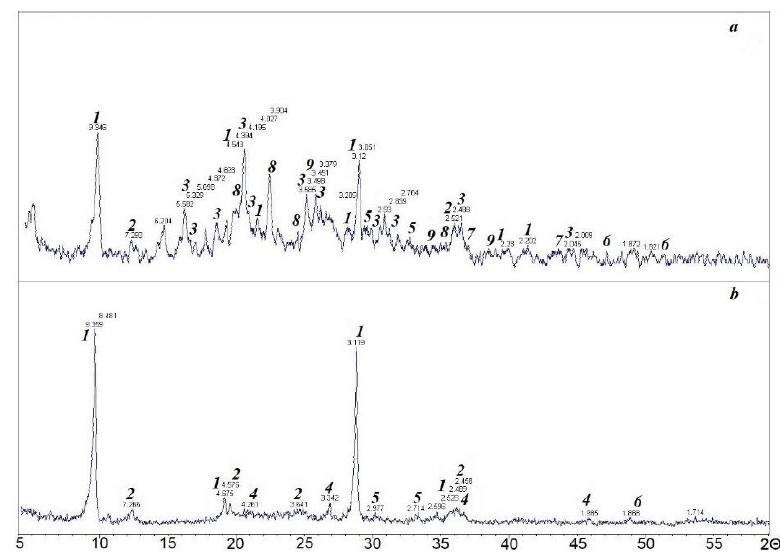
Figure 5. XRD pattern of the clinker after roasting at 450 °C ( a ) and of the leaching residue ( b ). Numbers indicate reflexes: 1—talc; 2—coquimbite; 3—mohrite; 4—pyrrhotite; 5—pentlandite; 6—magnetite; 7—nickel sulfate; 8—chalcocyanite.